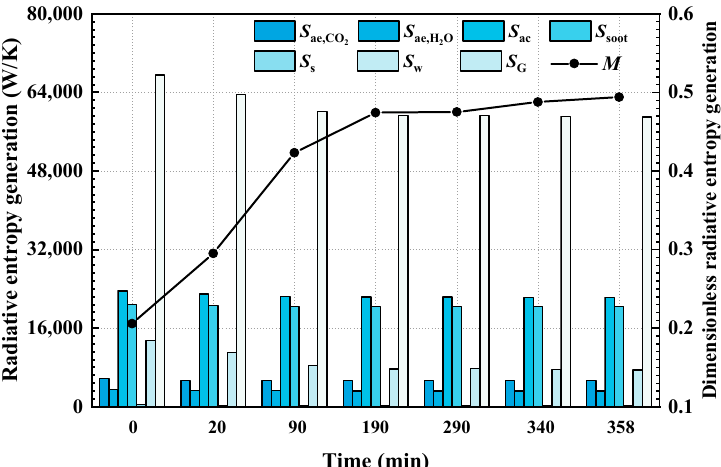
Figure 8. The total entropy generation rate and entropy generation rate due to various reasons during the combustion process of sub-bituminous coal (Wyoming).